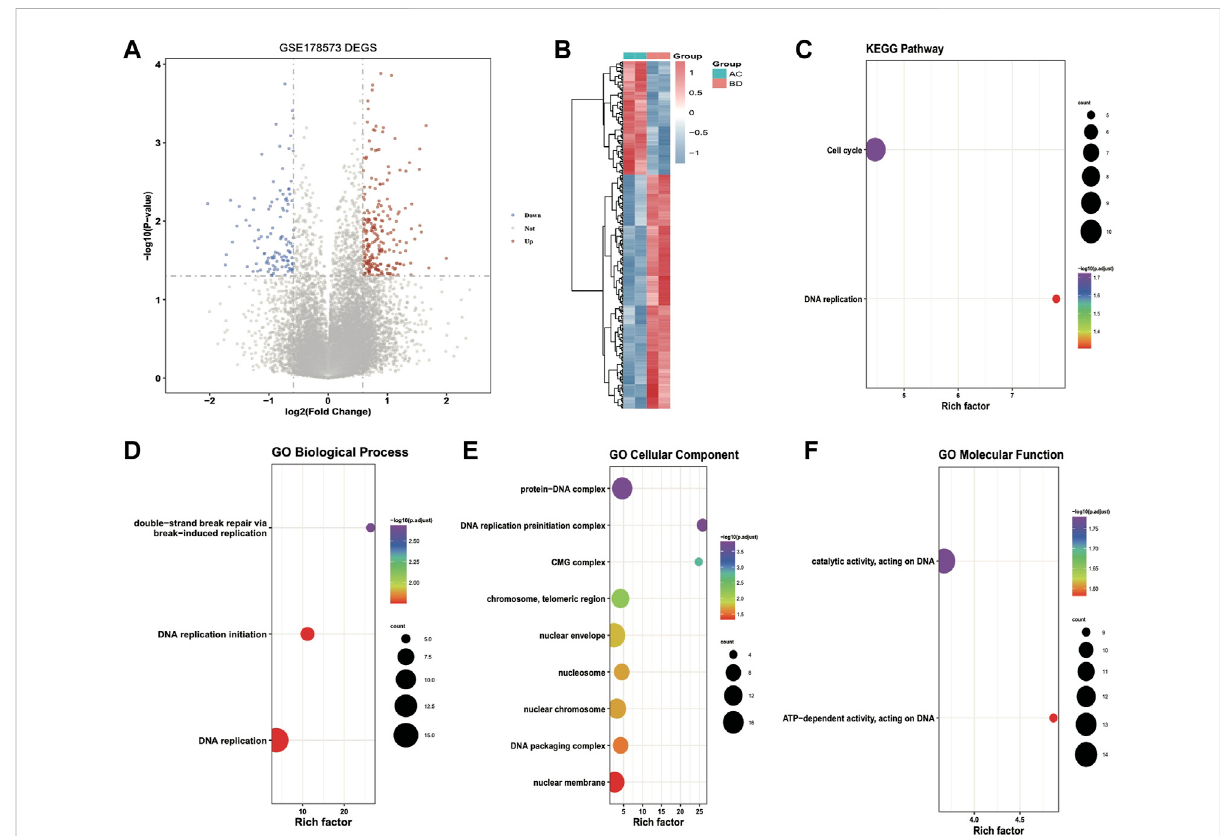
FIGURE 3 Results of differential expression analysis and functional enrichment analysis of GSE178573 dataset. (A) volcanic plot of differentially expressed genes in ultrasound and non-ultrasound groups; (B) thermographic of differentially expressed genes, red highlights high expression, blue highlights low expression; (C – F) Enrichment of differentially expressed genes for KEGG, BP (biological process), CC (cellular component), MF (molecular function) Pathway bubble plots, where the dot ’ s size demonstrates the number of enriched differentially expressed genes, and the color demonstrates the signi fi cance of the enrichment